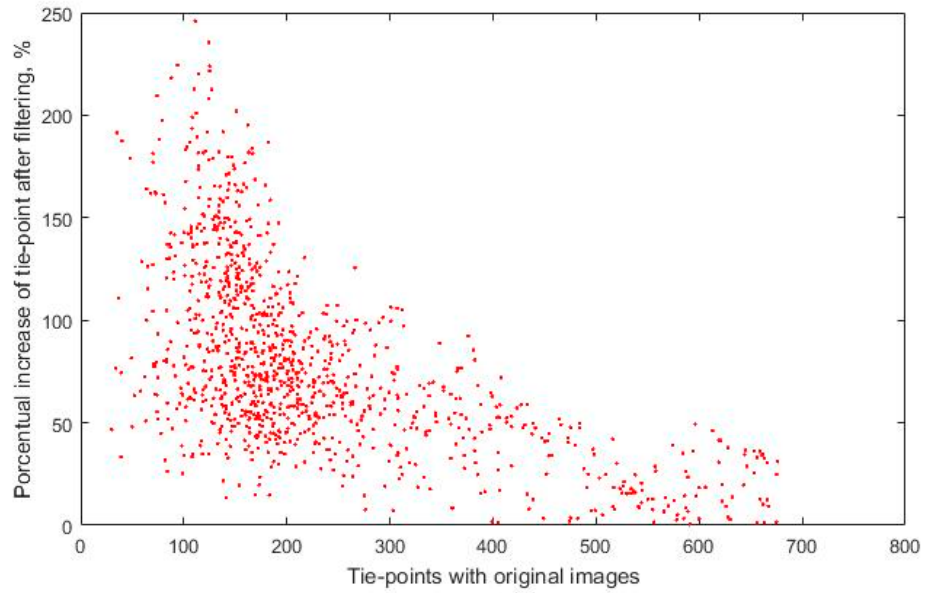
Figure 10. Increase in coincident points after Wallis filter application.